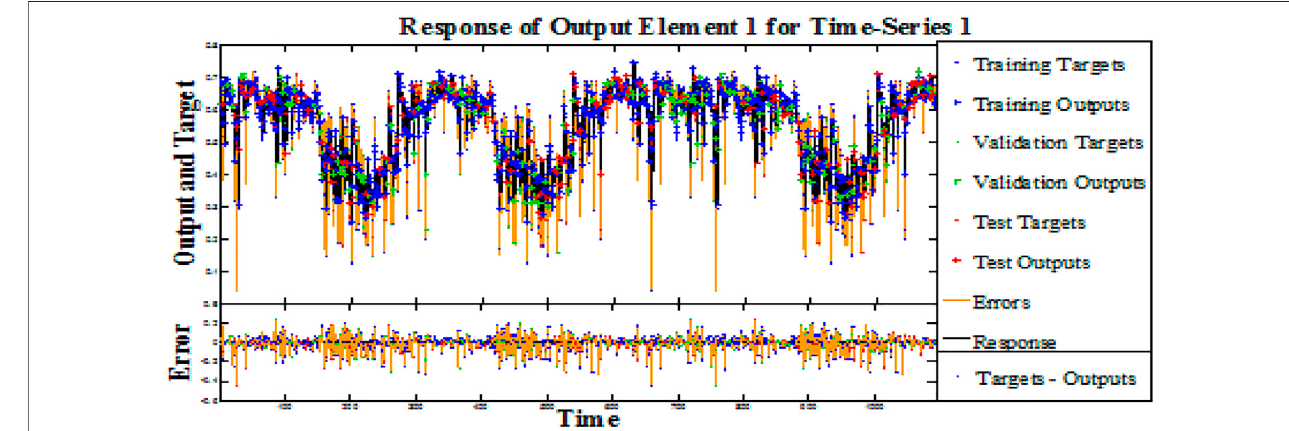
FIGURE 11 | Figure showing error response.